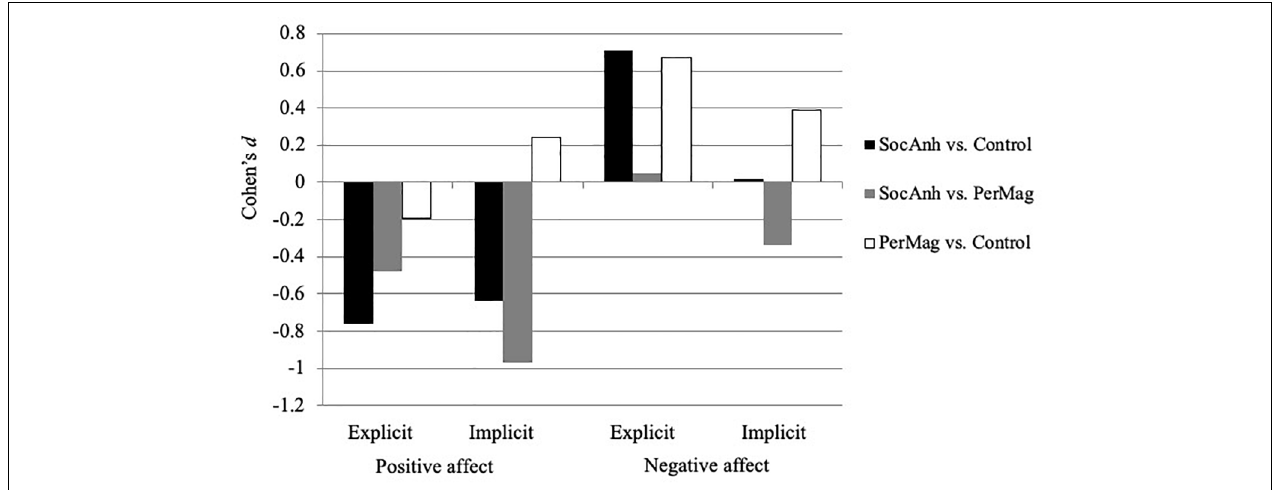
FIGURE 1 | Effect sizes (Cohen’s d ) for each group comparison on measures of explicit and implicit